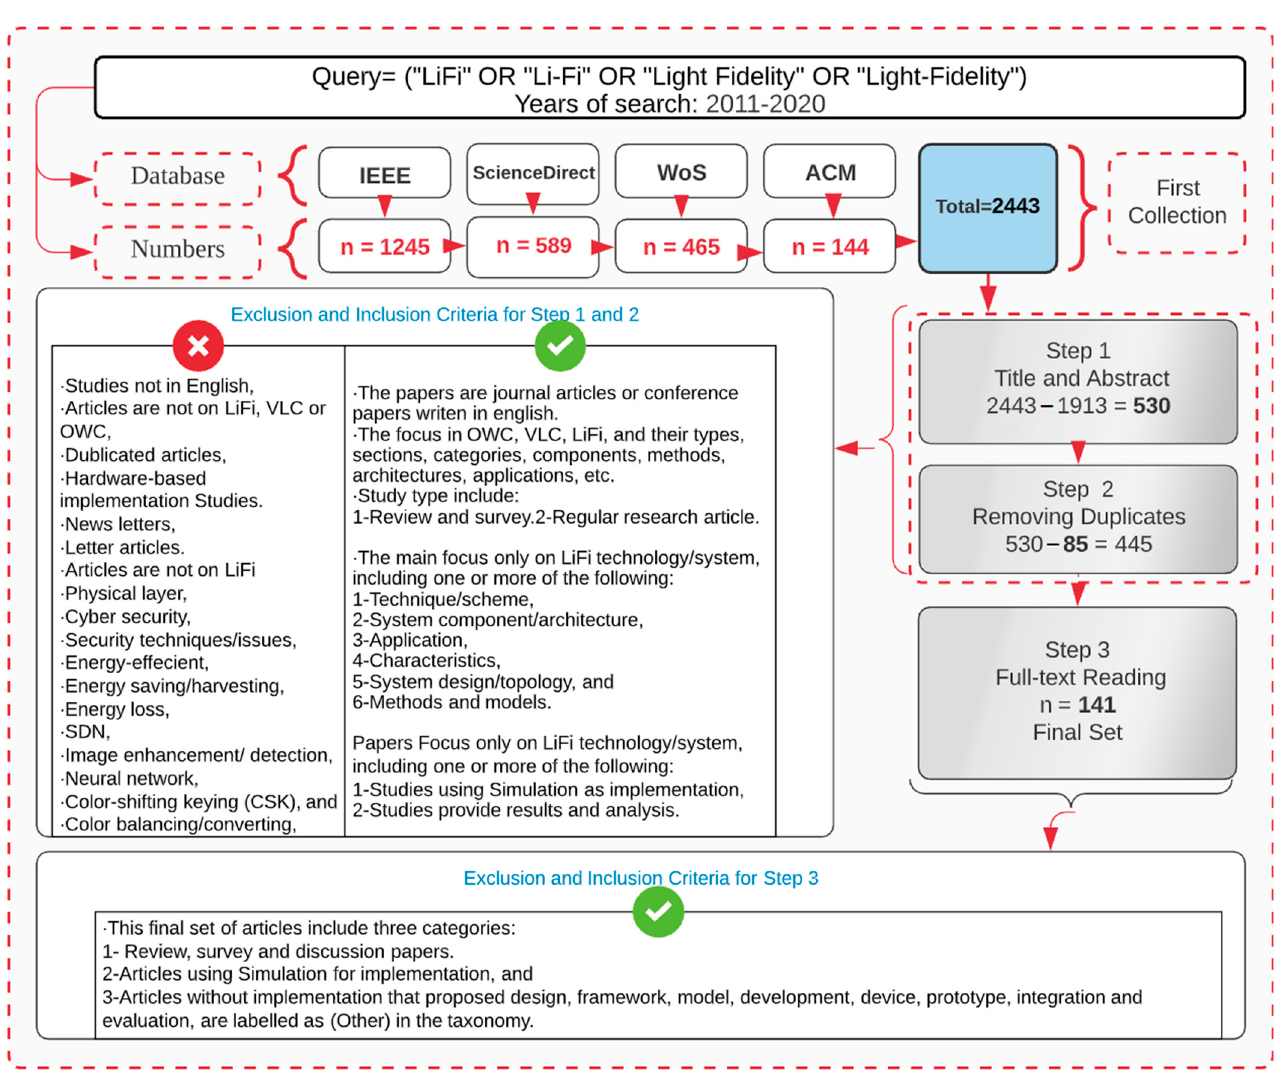
Figure 1. Development Study selection, including search query, inclusion criteria, and exclusion criteria.